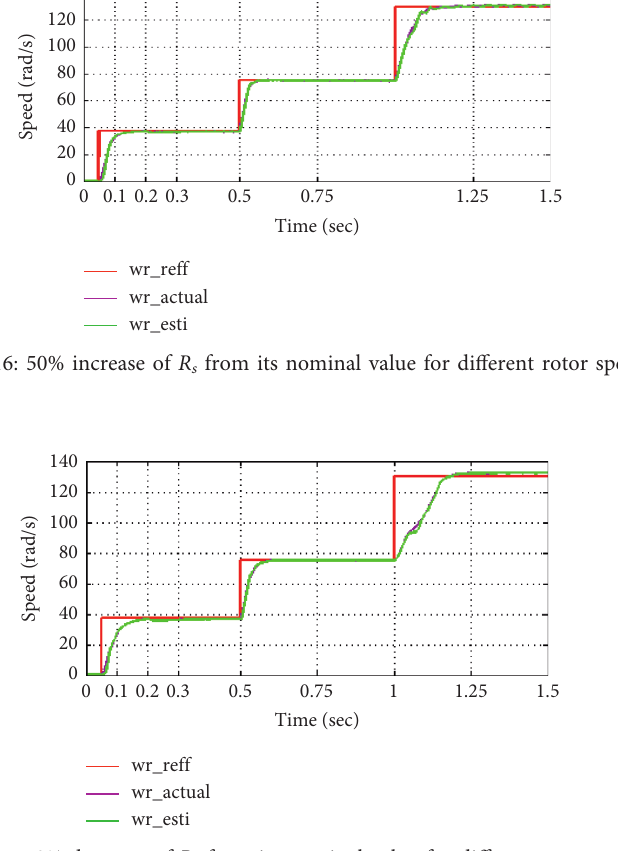
r from its nominal value for different